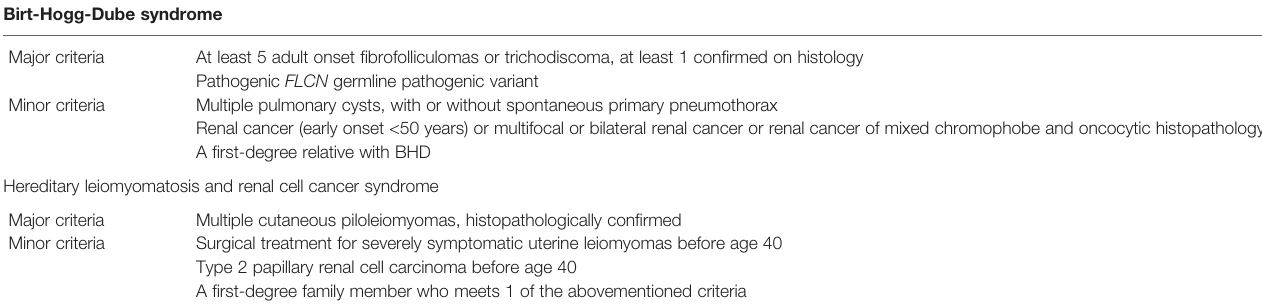
TABLE 1 | Diagnostic criteria for Birt-Hogg-Dube syndrome and hereditary leiomyomatosis and renal cell cancer syndrome. Birt-Hogg-Dube